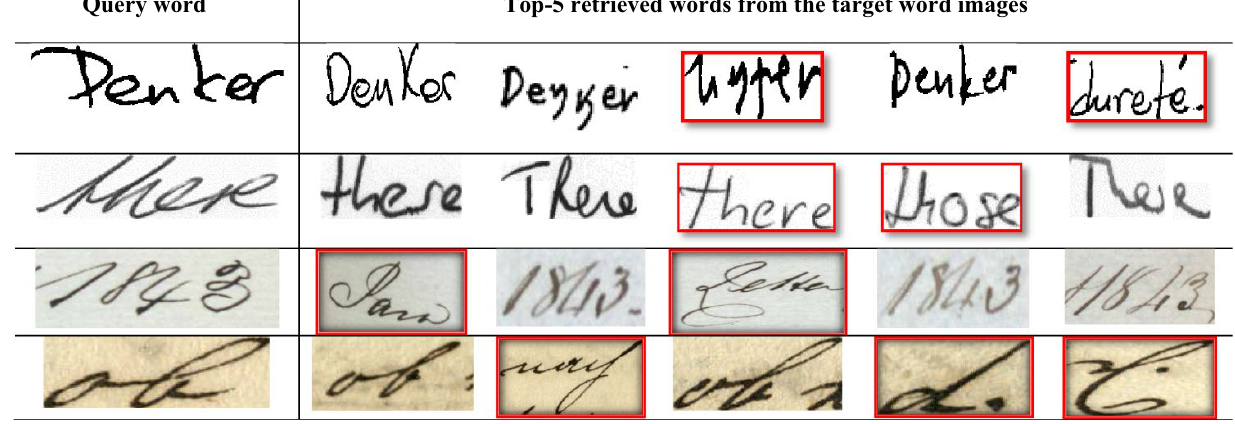
Fig. 14 Examples of top-5 retrieved target word images for given query word images. The word images marked within the red-colored bounding boxes indicates erroneous retrieval. The first, second, third, and fourth rows show the retrieval results on ICFHR 2014 H-KWS